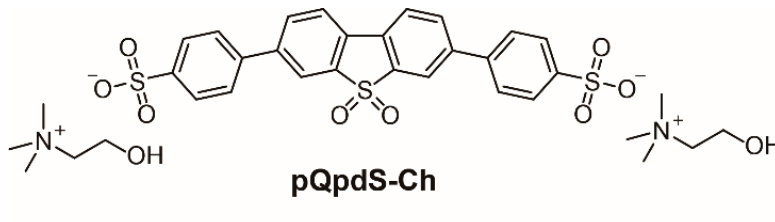
Figure 1. Molecular structure of pQpdS-Ch .